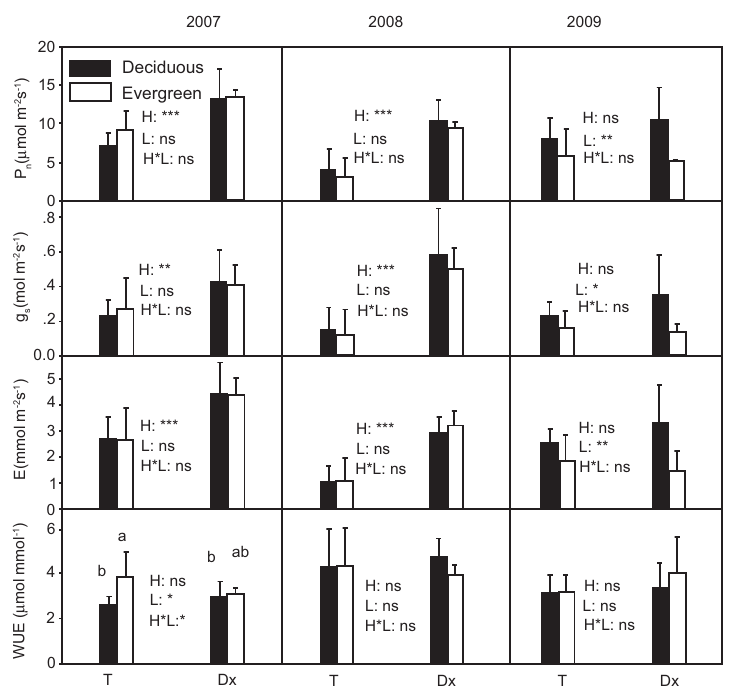
Figure 1. Photosynthetic gas exchange characteristics. Effect of habitat (H), leaf phenology (L), and their interaction (H × L), on Pn, g E, and WUE (mean ± SD, n = 3–5) of the tree species in two habitats. T and Dx represent the two study sites Tianlongshan and Daxiagu, respectively. Measurements were conducted under ambient conditions in 2007 and 2008, and under controlled conditions in 2009. The significance levels (*** = P < 0.001, ** = P < 0.01, * = P < 0.05, and ns = P > 0.05) were based on ANOVA results.